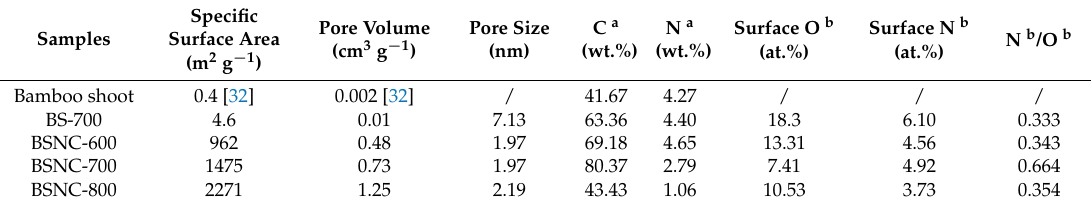
Table 2. The physicochemical properties of the obtained carbon